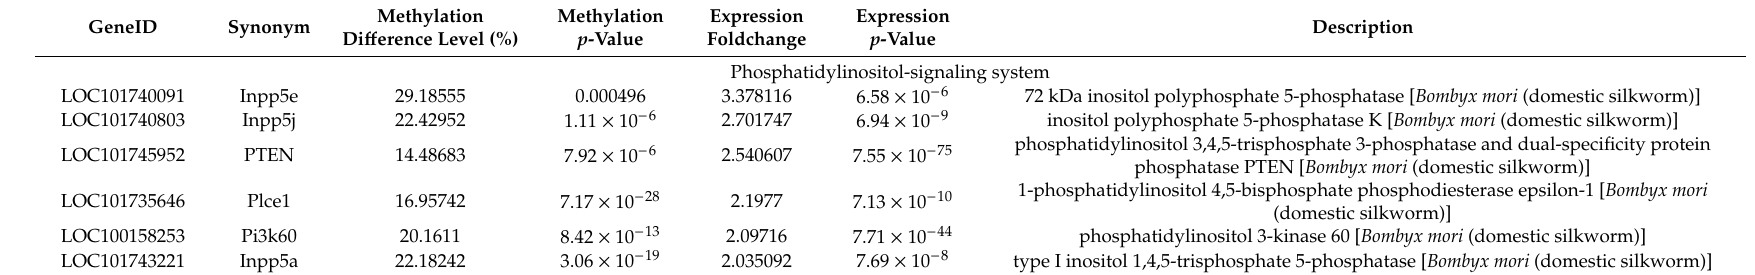
Table 4. Methylomes- and transcriptome-associated genes involved in phosphorylation.